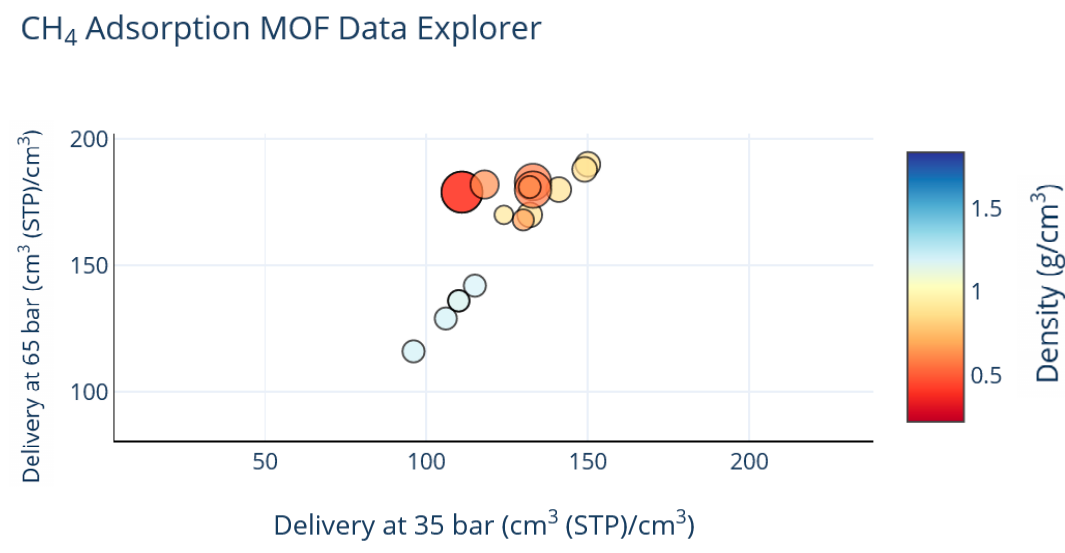
Figure 9. QSPR for CH 4 storage in MOFs. CH 4 volumetric delivery (cm 3 (STP)/cm 3 ) at 298 K, 65 bar and at 35 bar. Each point represents a MOF. The data points are color-coded for MOF density, and the diameter of each circle represents the largest cavity diameter (LCD) of each MOF.